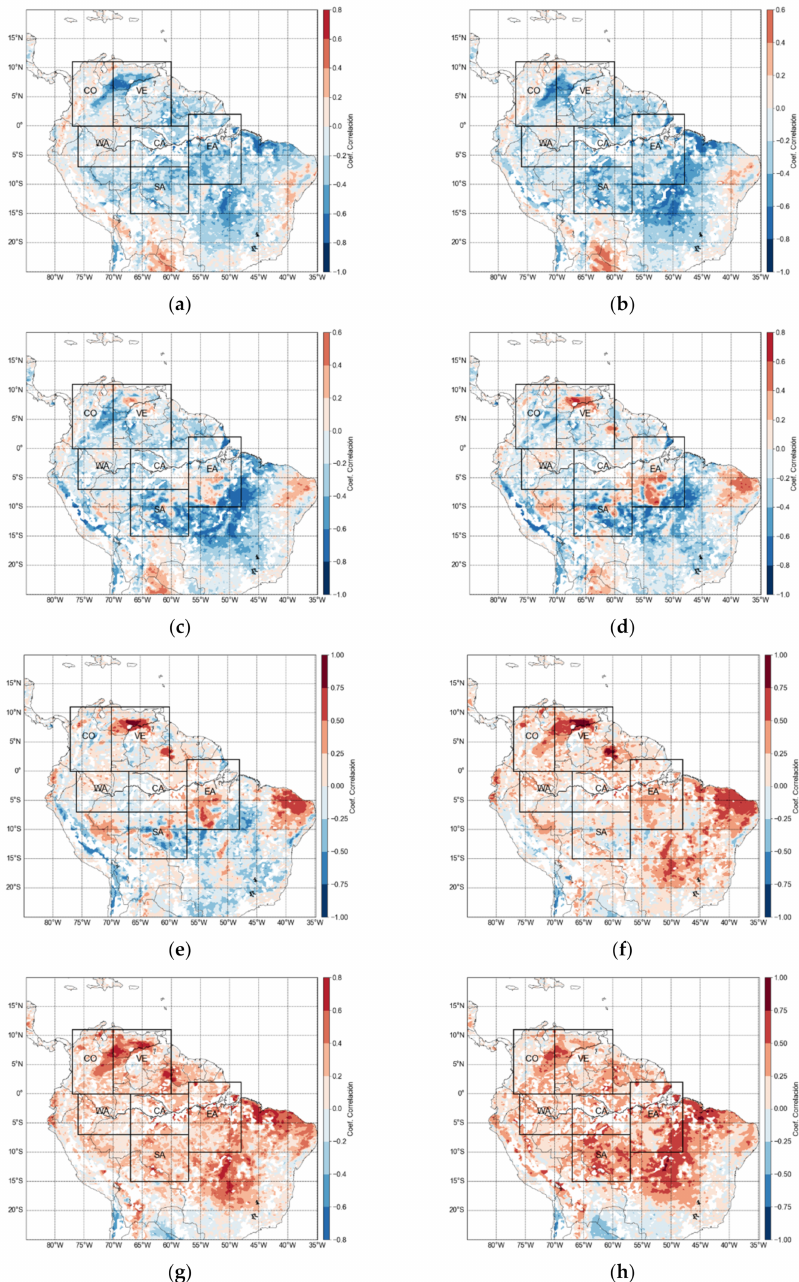
Figure 4. Maps of pixel-by-pixel lagged cross-correlations between NDVI and SMOS. Results show NDVI leading SMOS by: ( a ) 4 months; ( b ) 3 months; ( c ) 2 months; ( d ) 1 month; ( e ) 0 (simultaneous). Results for SMOS leading NDVI by: ( f ) 1 month; ( g ) 2 months; and ( h ) 3